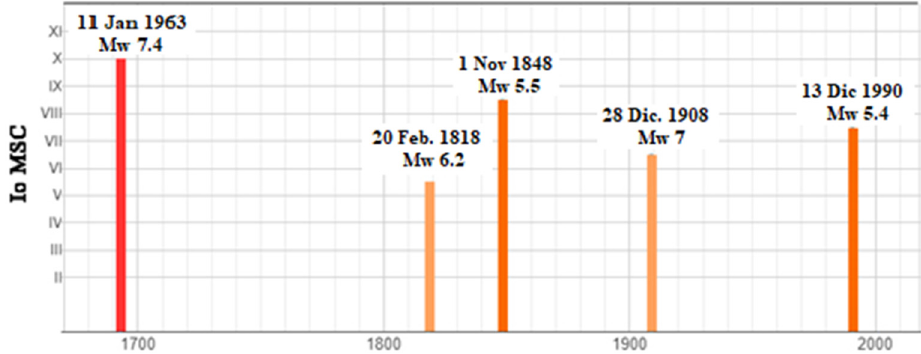
Figure 2. Timeline of earthquakes in the city of Augusta (After Locati et al. [17], modified, INGV database). The earthquake on 11 January 1693, known as “Val di Noto earthquake,” struck a vast territory of Southeastern Sicily. It had an estimated magnitude of 7.4 on the moment magnitude scale and caused the partial, and, in many cases, total, destruction of 57 cities and 60,000 casualties [18,19,20].